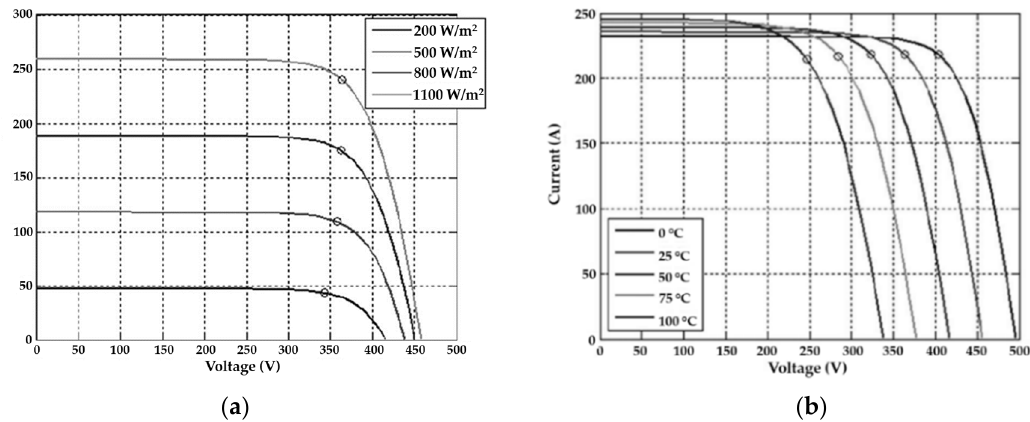
Figure 9. Effects of: ( a ) solar radiation; and ( b ) air temperature shift on P–V characteristic curve [81]. The relationship of irradiance and ambient temperature to the power output ( P pv ) can be expressed by Equations (17) and (18) [82,83] and the real electric power ( P e , pv ) that is converted from direct current to alternative current and injected in a power system is calculated by Equation (19) as